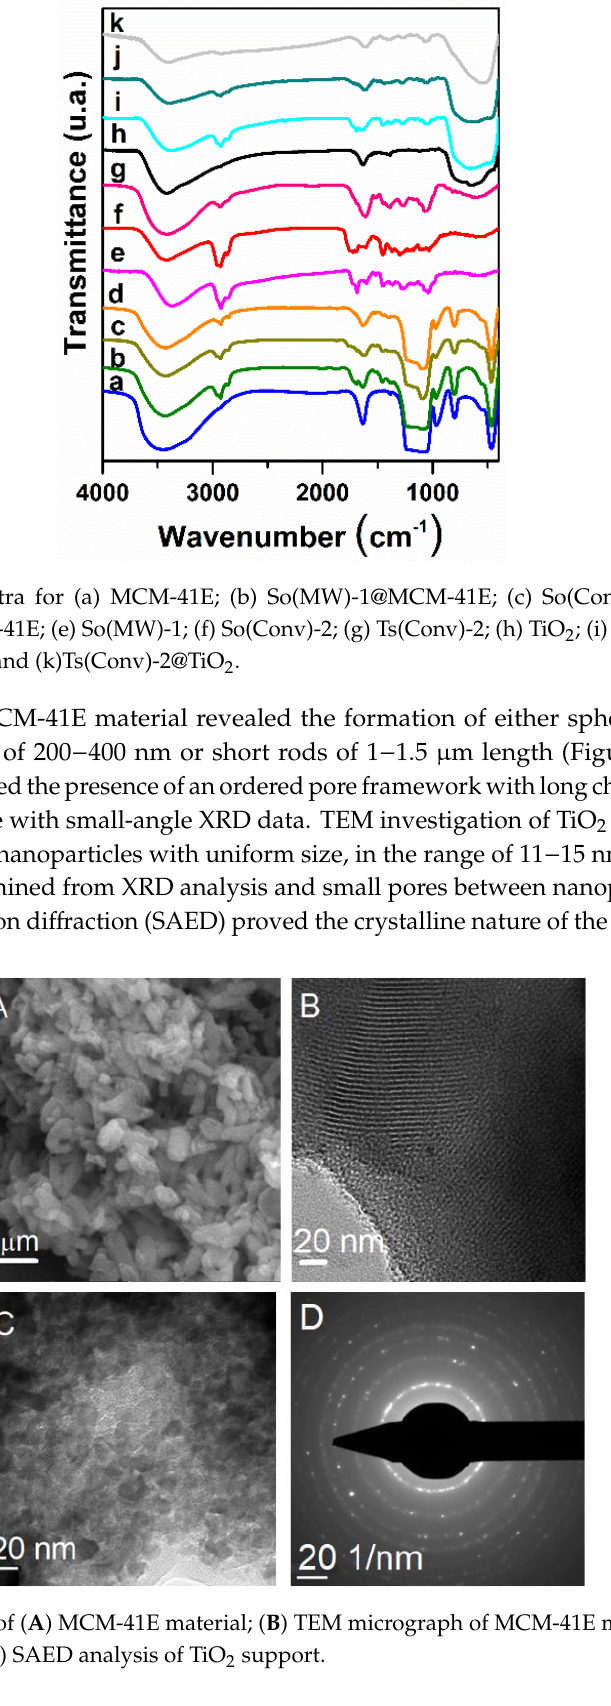
Figure 3. ( A ) Small-angle XRD analysis of MCM-41E and ( B ) wide-angle XRD patterns of TiO 2 E and TiO 2 calcined at 450 °C. The FTIR spectrum of the MCM-41E material evidenced the characteristic bands of silica matrix: asymmetric and symmetric stretching vibrations of Si–O–Si bonds at 1096 cm −1 and 814 cm −1 , respectively, the band of silanol groups at 964 cm −1 and the bending vibrations of Si–O–Si bonds at